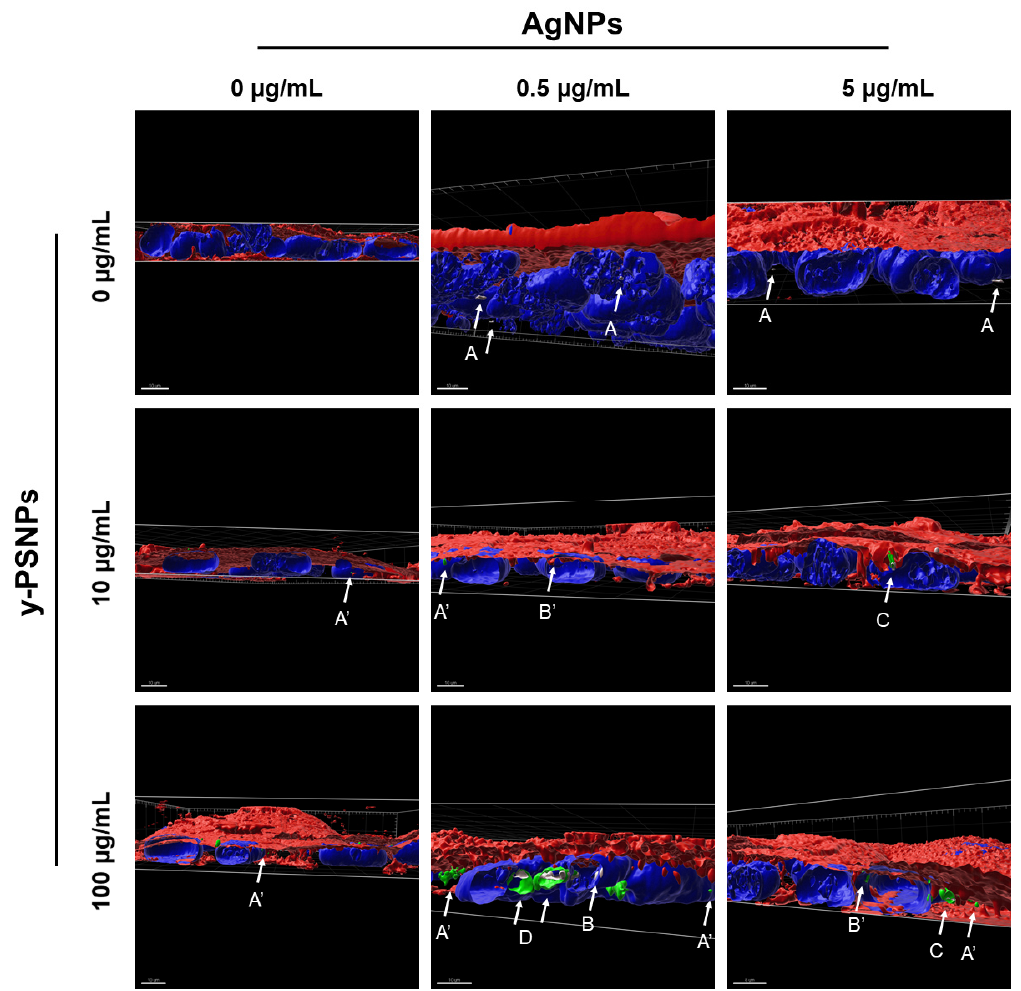
Figure 5. Selection of representative three-dimensional images of the Caco-2 cells exposed to 0, 0.5 or 5 µ g/mL AgNPs combined with 0, 10 and 100 µ g/mL y-PSNPs for 24 h. Nuclei and cell membranes were stained with Hoechst (blue) and CellMask (red), respectively. y-PSNPs particles are shown in green and AgNPs are shown in grey. Arrows point out: AgNPs and y-PSNPs located inside the cells (indicated as A and A’, respectively); AgNPs and y-PSNPs located inside the nuclei (indicated as B and B’, respectively); AgNPs/y-PSNPs complexes located inside the cells (indicated as C); and AgNPs/y-PSNPs complexes located inside the nuclei (indicated as D). Imaris 9.5 was used to process the images and take the shown snapshots. Two different experiments were carried out and two different randomly chosen fields were